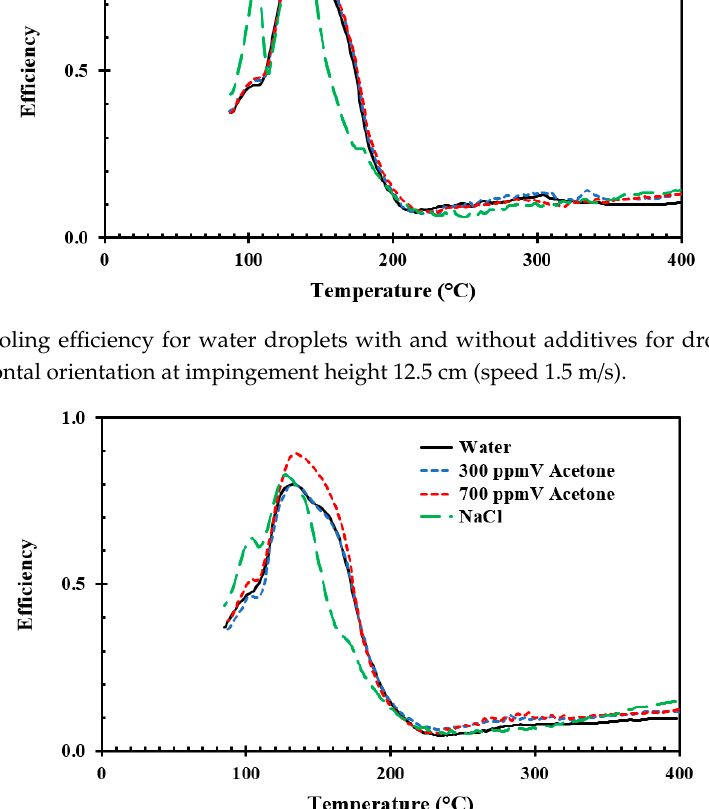
Figure 14. Cooling efficiency for water droplets with and without additives for droplet diameter 2.5 mm, horizontal orientation at impingement height 25 cm (speed 2.2